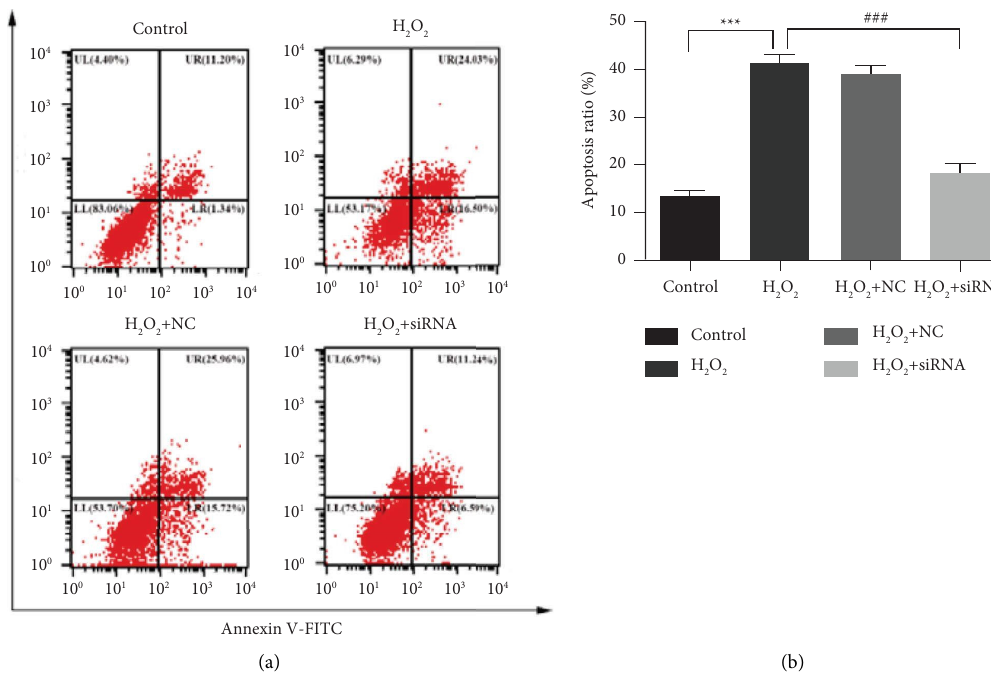
Figure 5: Knocking down Ndufs4 prevented H 2 O 2 -induced apoptosis in H9c2 cells. (a) Flow cytometry analyzed the H9c2 cell apoptosis ratio of each group after Annexin V-FITC/PI double staining. (b) Te apoptosis ratio is shown in the graph. In the H 2 O 2 group, cell apoptosis was signifcantly higher than that in the control group, but the cell apoptosis rate of the H 2 O 2 + siRNA group was signifcantly lower than that of the H 2 O 2 group ( P < 0 . 001). Data were expressed as mean ± SD ( n � 3). ∗ P versus the control group, ∗∗∗ P < 0 . 001; # P versus the H ### P < 0 . 001; $ P versus the H $$ P < 0 . 2 O 2 group, 2 O 2 + NC group,